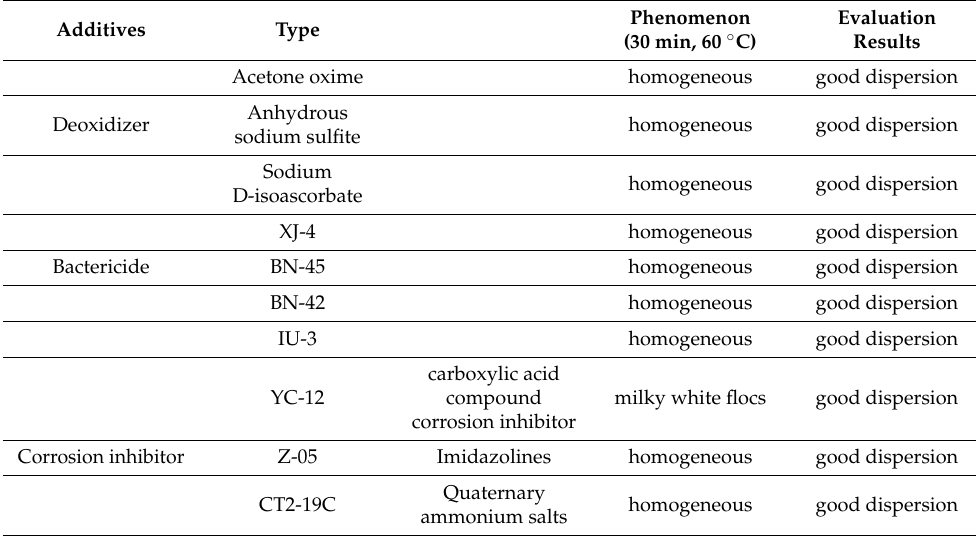
Table 3. Results of the compatibility of the injected water with additives.